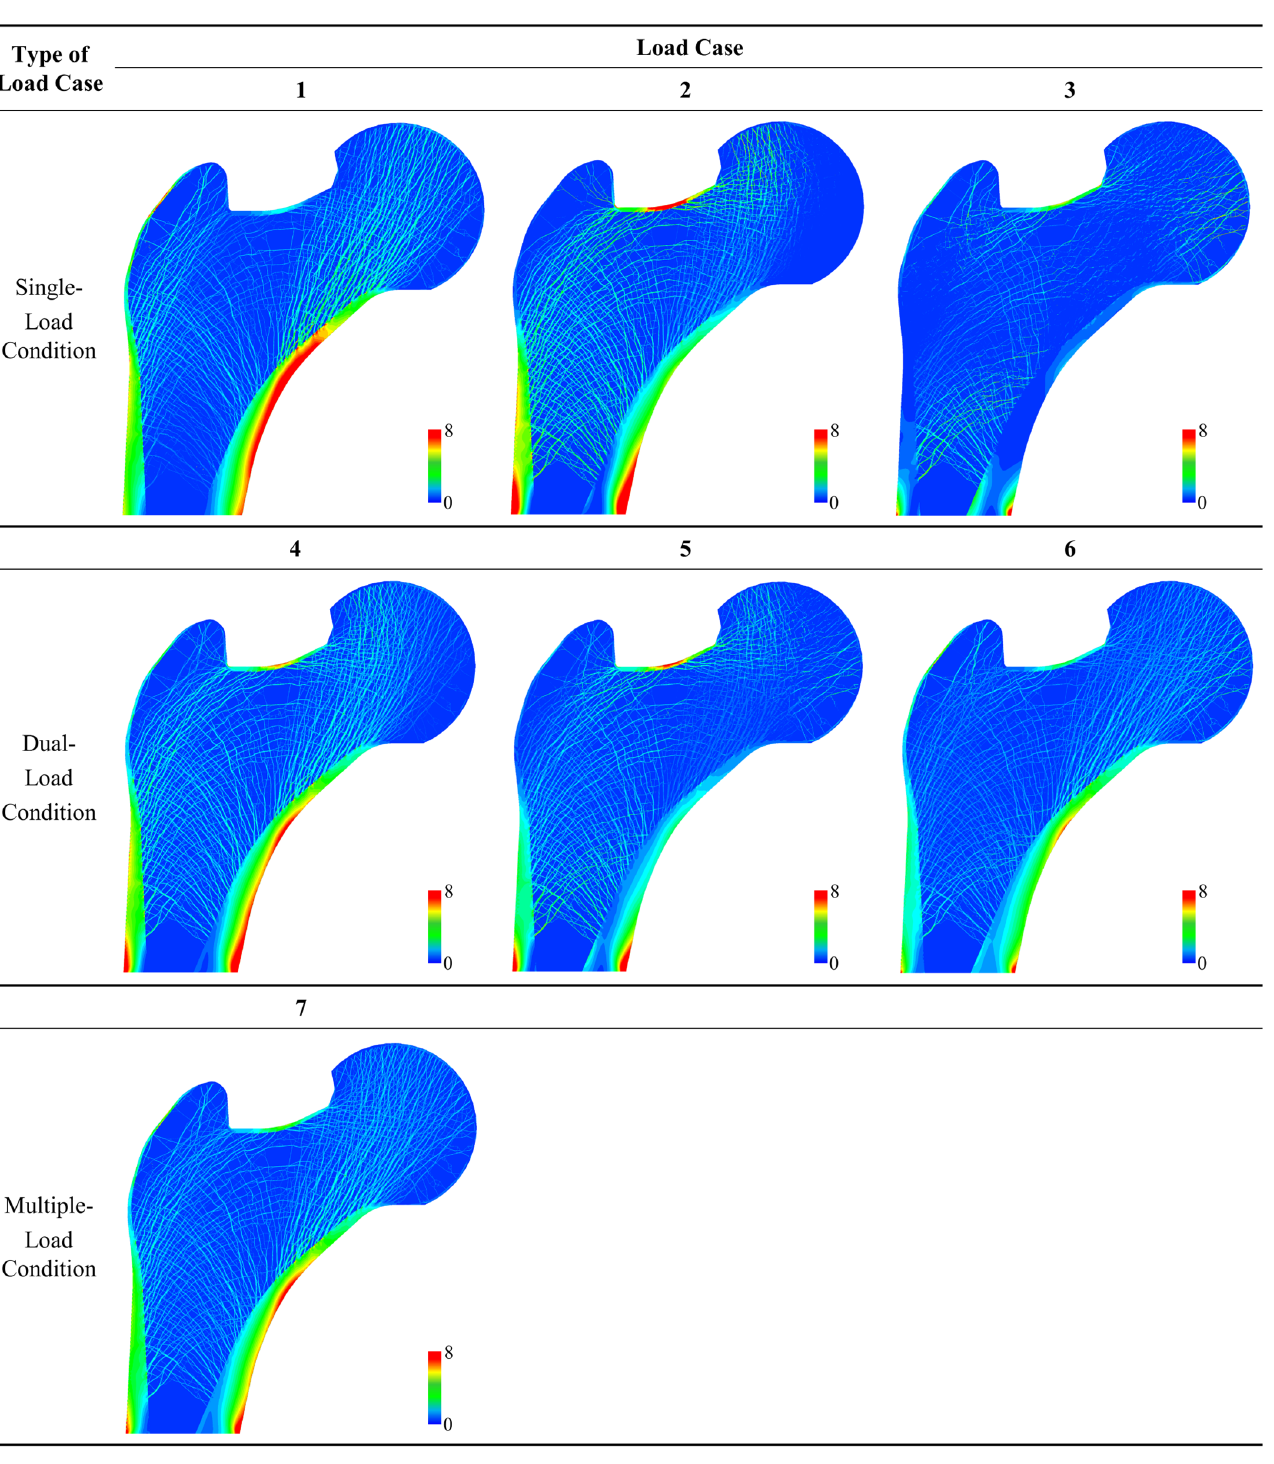
Figure 5. Strain energy density (J/mm 2 ) contours for global model for each load case.